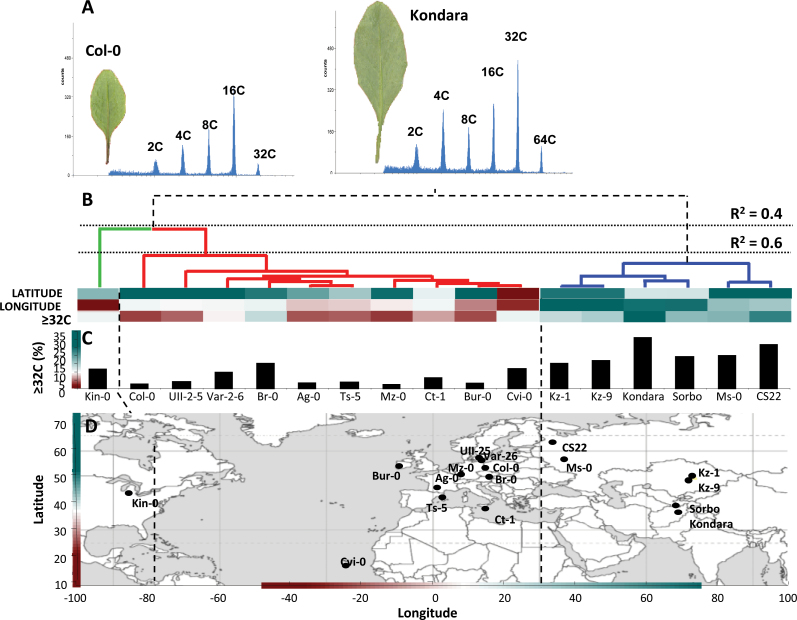
Somatic endopolyploidy varies in the leaves of Arabidopsis accessions. (A) Endoreduplication profile in the fifth leaf of Col-0 and Kondara. The fifth rosette leaf at maturity is featured (adaxial side) at the left of each graph (see also Supplementary Table S1 available at JXB online). (B) Hierarchical clustering for the ≥32C ploidy and corresponding geographical coordinates (longitude, latitude) at the original sites of collection. Minimum similarity for cluster partition is given as R
2 values. Different clusters within the cladogram are depicted in different colours: blue, Central Asia/Russia; red, Europe; green, America. Longitudinal/latitudinal positioning and the endopolyploidy values are depicted by colour-coded gradient scale (refer to Figs. C and D). (C) Distribution of the high endopolyploidy fragments (≥32C) of Arabidopsis accessions relative to their geographic origin. Values are mean of three biological replicates expressed as percentage of the total nuclei counted. (D) Geographic origins of the Arabidopsis accessions (see also Supplementary Table S1 available at JXB online).